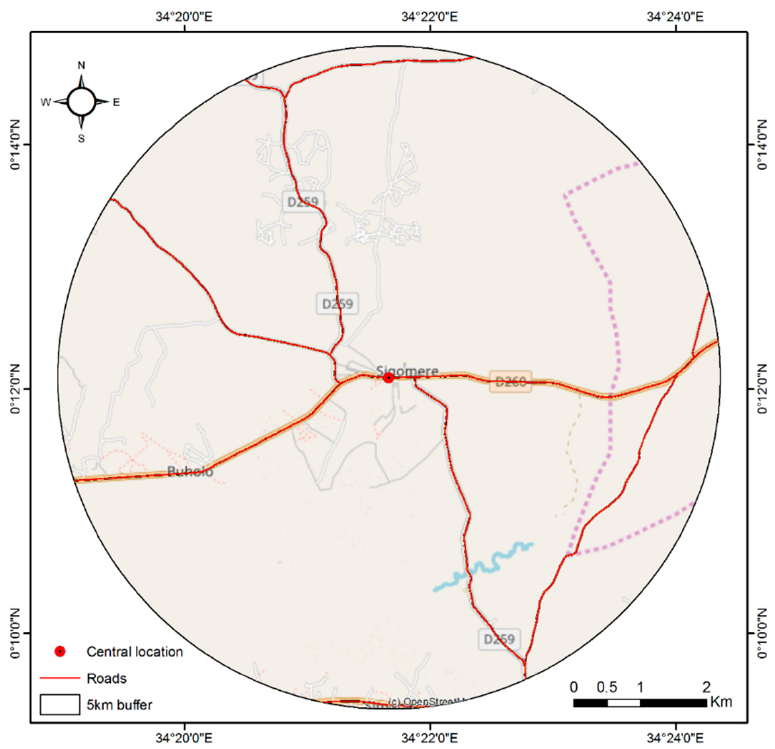
Figure 1. Map of the study area representing official roads as captured in the data by national mapping agency superimposed on OpenStreetMap (OSM).